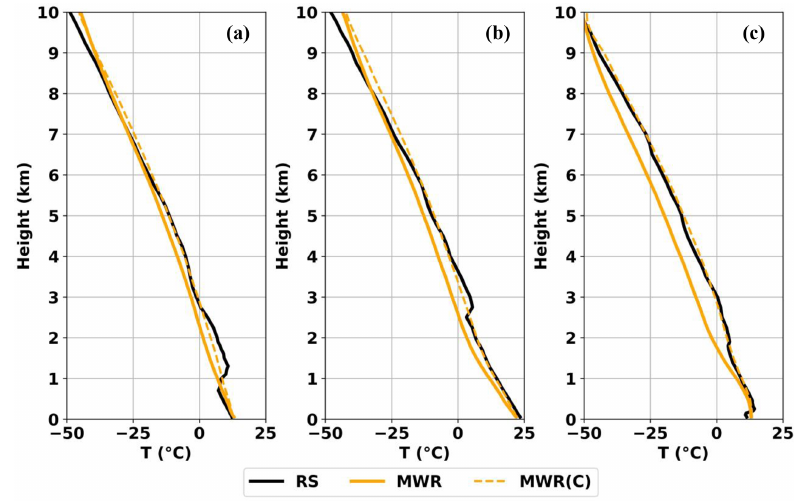
Figure 7. Vertical profiles of temperature ( T ) measured by RS and MWR, original and corrected (C), at (a) 23:00UTC on 2 May (precipita- tion day), (b) 23:00UTC on 28 July (cloudy day), and (c) 11:00UTC on 2 May 2021 (clear-sky day) at